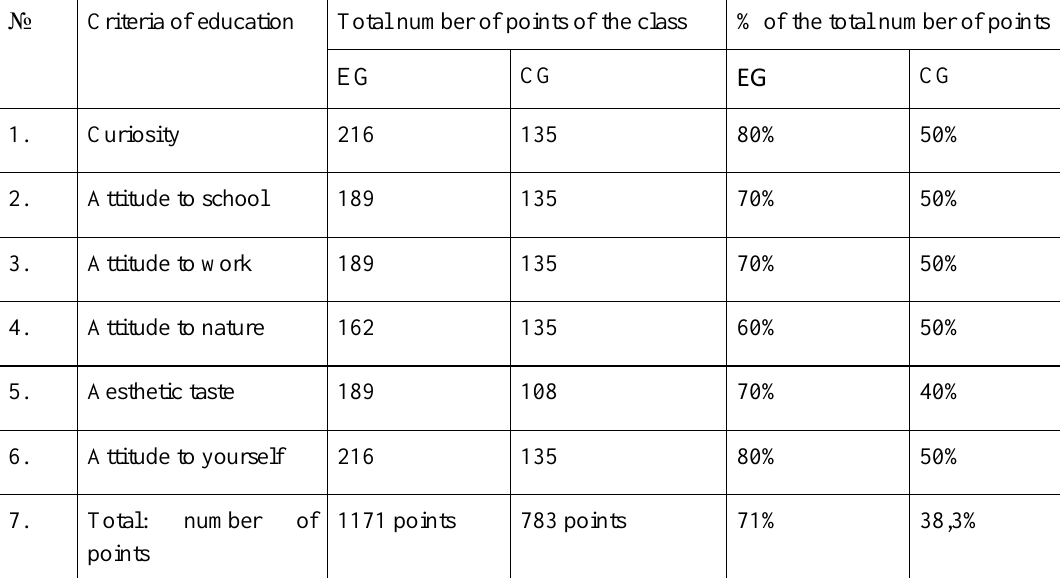
Table 4. The level of cooperation in the children's team (the method of Kapustin) (experimental group)